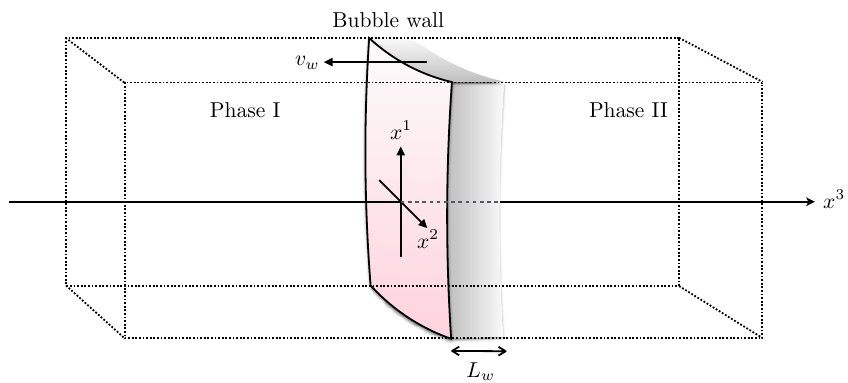
(cid:30) i = v (cid:30) ) expanding over the false vacuum ( i h i 6